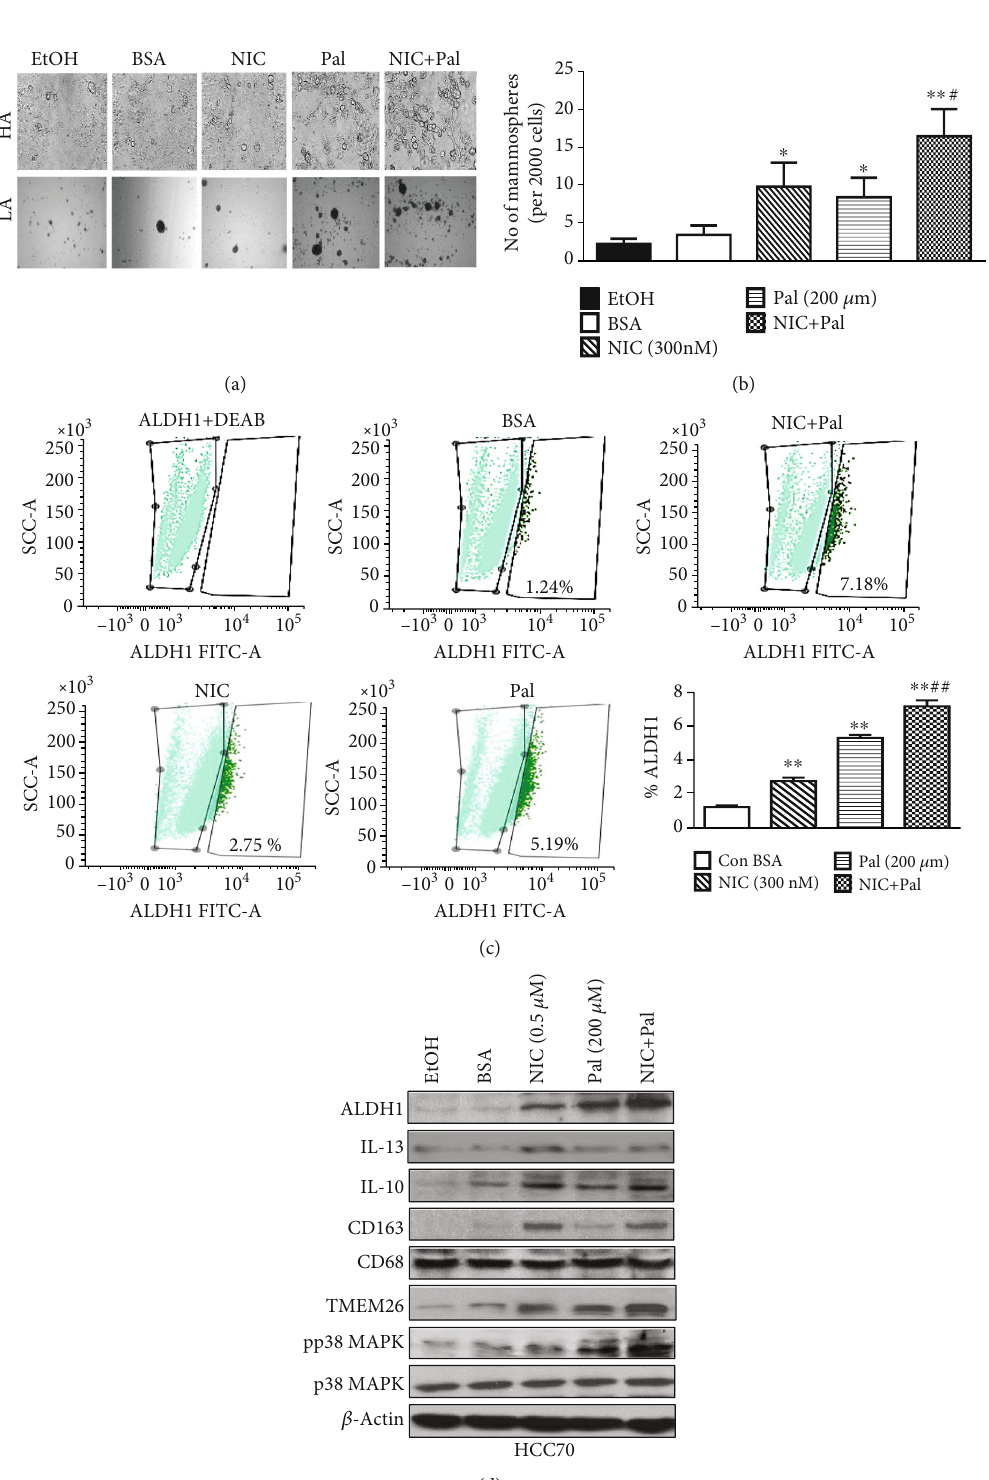
Figure 3: Treatment of breast cancer cells, in vitro , with NIC and Pal increases MCSCs, anti-in fl ammatory cytokines, and tissue-resident macrophage populations. (a) HCC70 cells were plated under low attachment (LA) conditions as mammospheres and treated with either NIC or BSA-conjugated palmitate (Pal) alone or in combination for 48 h. A representative picture of the mammospheres after various treatments. (b) Quantitation of the mammosphere numbers after various treatments for 48 h. (c) Treatment of HCC70 cells with NIC ± PAL or vehicles was subjected to FACS analysis after performing Alde fl uor assay for quantitation of ALDH1-positive population in various treatment groups. (d) Western blot analysis of macrophage (CD68 and CD163) and anti-in fl ammatory (IL13 and IL10) cytokine markers, MCSCs (ALDH1), and beige adipocyte (TMEM26) marker and stress kinase (p38MAPK). ∗ p ≤ 0 : 05 and ∗∗ p ≤ 0 : 01 compared to saline or # p ≤ 0 : 05 and ## p ≤ 0 : 01 compared to the NIC group alone ( n = 3